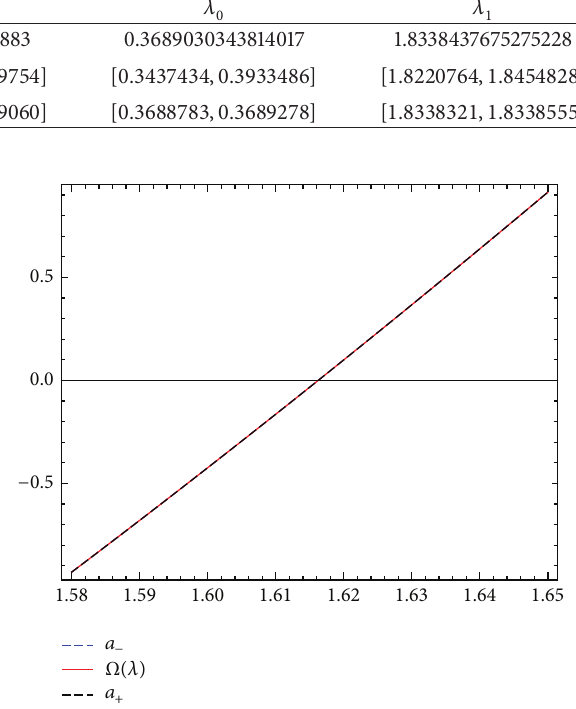
Figure 4: The enclosure interval dominating 𝜆 1 for ℎ = 0.1 , 𝑁 = 25 , and 𝜀 = 10 −5